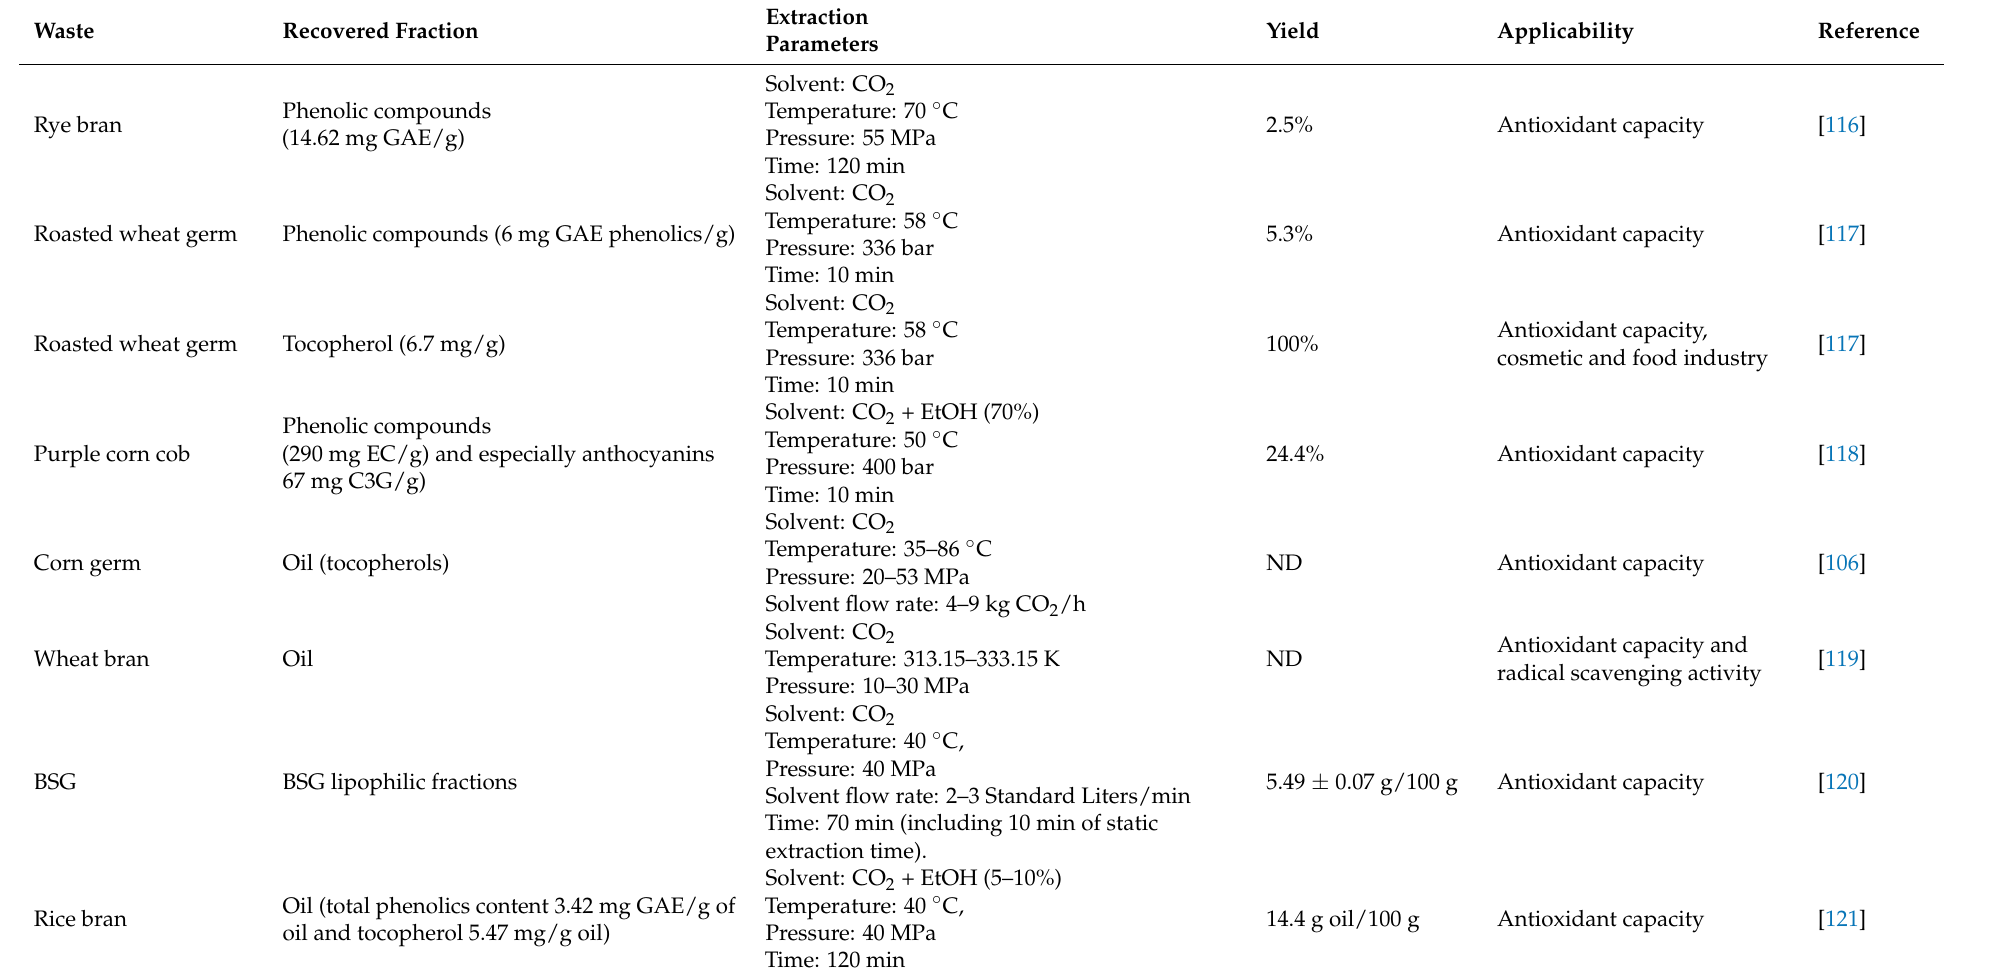
Table 5. The main bioactive compounds from cereal waste recovered using